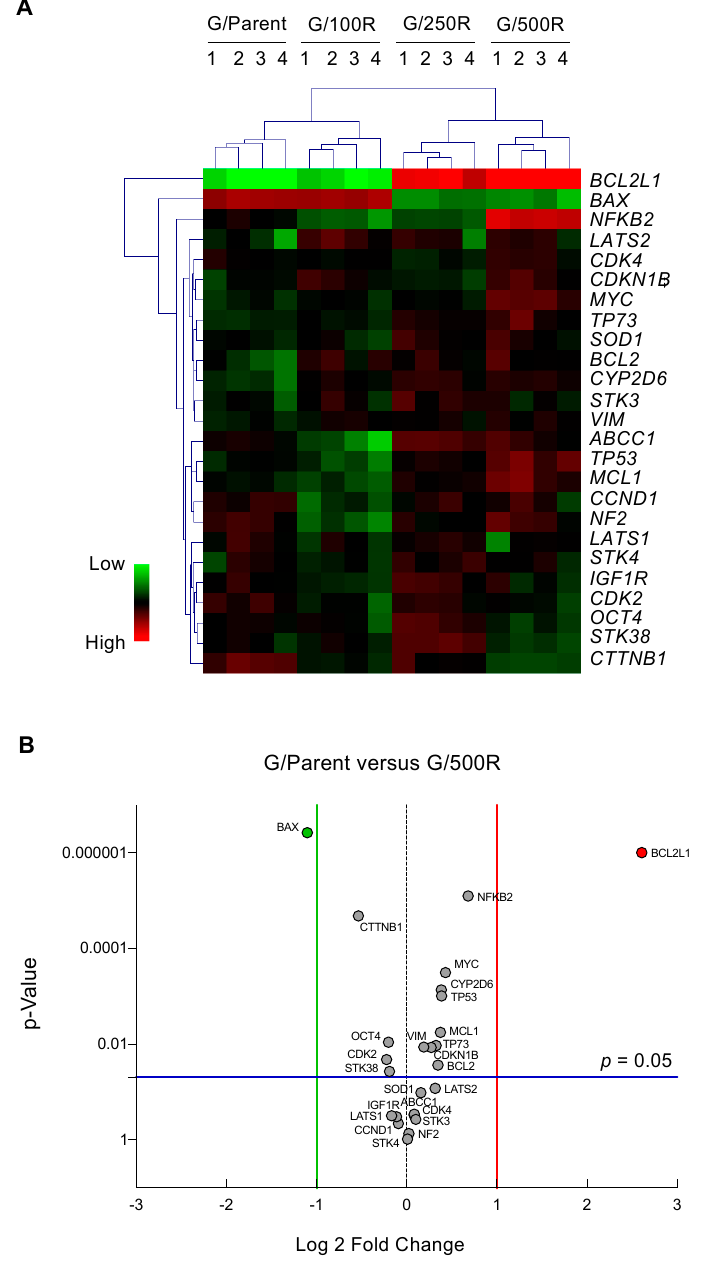
Figure 3. qPCR analysis of mRNA expression of putative cancer-related genes involved in drug resistance and cell survival of MCL. ( A ) Gene expression data in parental Z/Parent cells and BTZ- resistant Z/100R, Z/250R, and Z/500R cells from four independent experiments were normalized to housekeeping GAPDH , aligned, clustered, and represented in a heatmap. ( B ) Volcano plot of differentially expressed genes comparing Z/Parent and Z/500R cells with fold change > 2 and p < 0.05; two-sided Student’s t